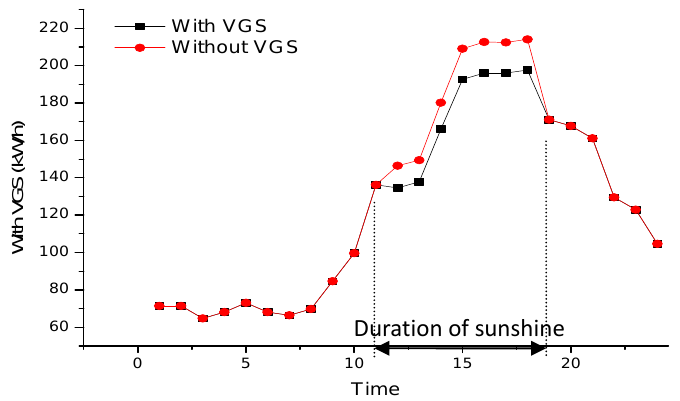
Figure 11. Daily savings in electricity consumption.